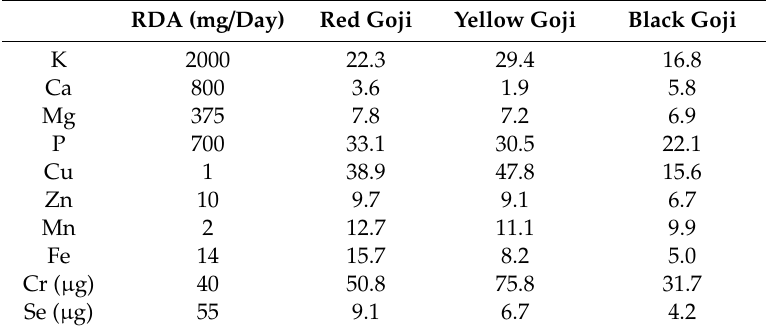
Table 4. Percentage contribution to the recommended daily allowance (RDA) of minerals for 100 g of goji berry fruits related to Regulation (EU) No. 1169 / 2011. RDA (mg /